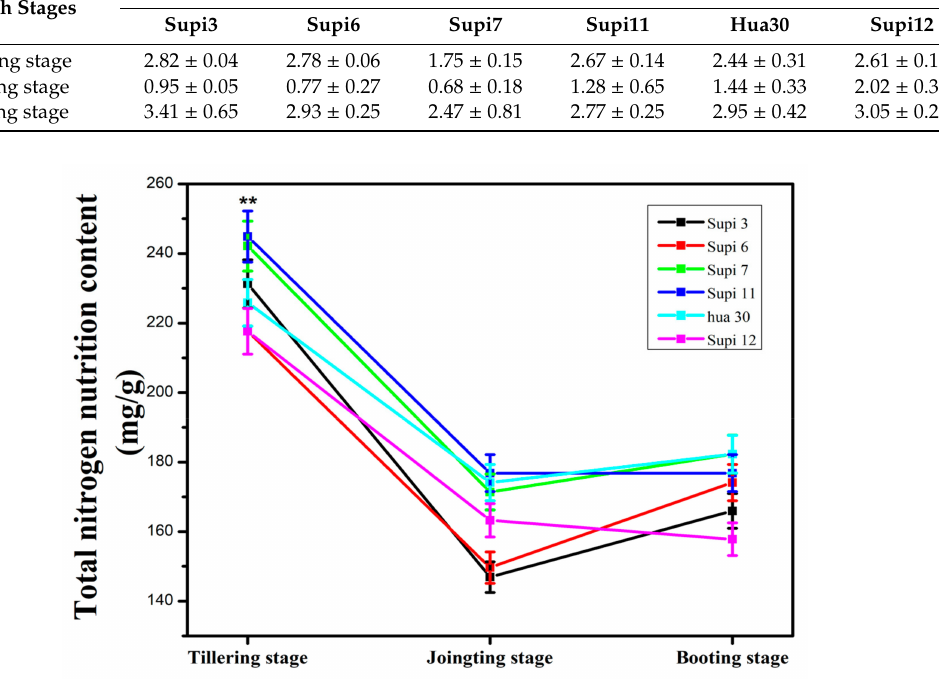
Figure 1. Changes of total nitrogen nutrition (TNN) content in the six barley cultivars at di ff erent developmental stages. Data represent mean values standard deviation (SD) from three independent experiments. Bars show standard deviations of the mean. Asterisks on top of the bars indicate statistically significant di ff erences ( ** p < 0.01, Student’s t